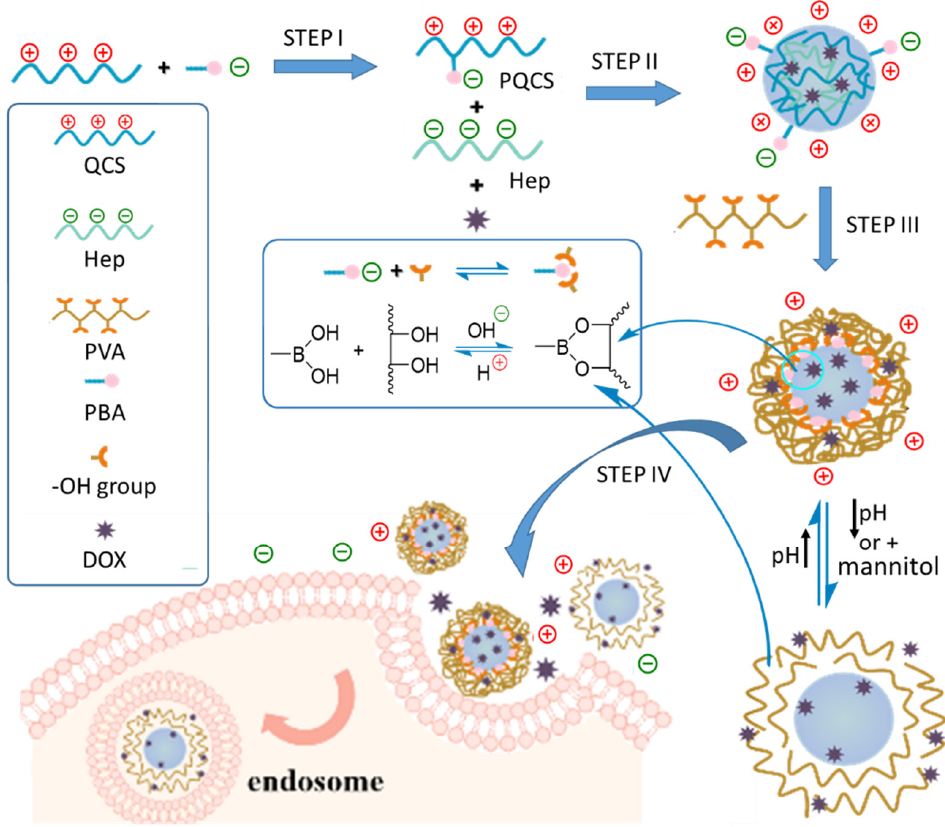
Figure 1. A schematic illustration of the procedures for the preparation of DOX-loaded nanoparti- cles (NPs), the mechanism of the dually responsive drug release, and cellular uptake of NPs. QCS = quaternized chitosan; PQCS = PBA-modified QCS; PBA = phenylboronic acid; Hep = heparin; PVA = poly(vinyl alcohol); DOX = doxorubicin.